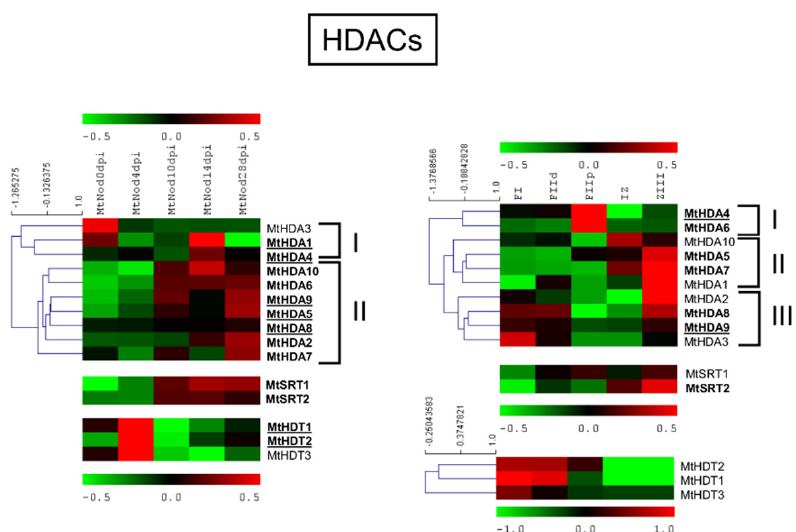
Figure 9. Heat map of MtHDACs in the ND experiment (on the left) and the LCM experiment (on the right). The main clusters are indicated by square brackets. In bold are the genes with an average expression above five in the ND experiment and above two in the LCM experiment. Genes with higher expression are underlined.